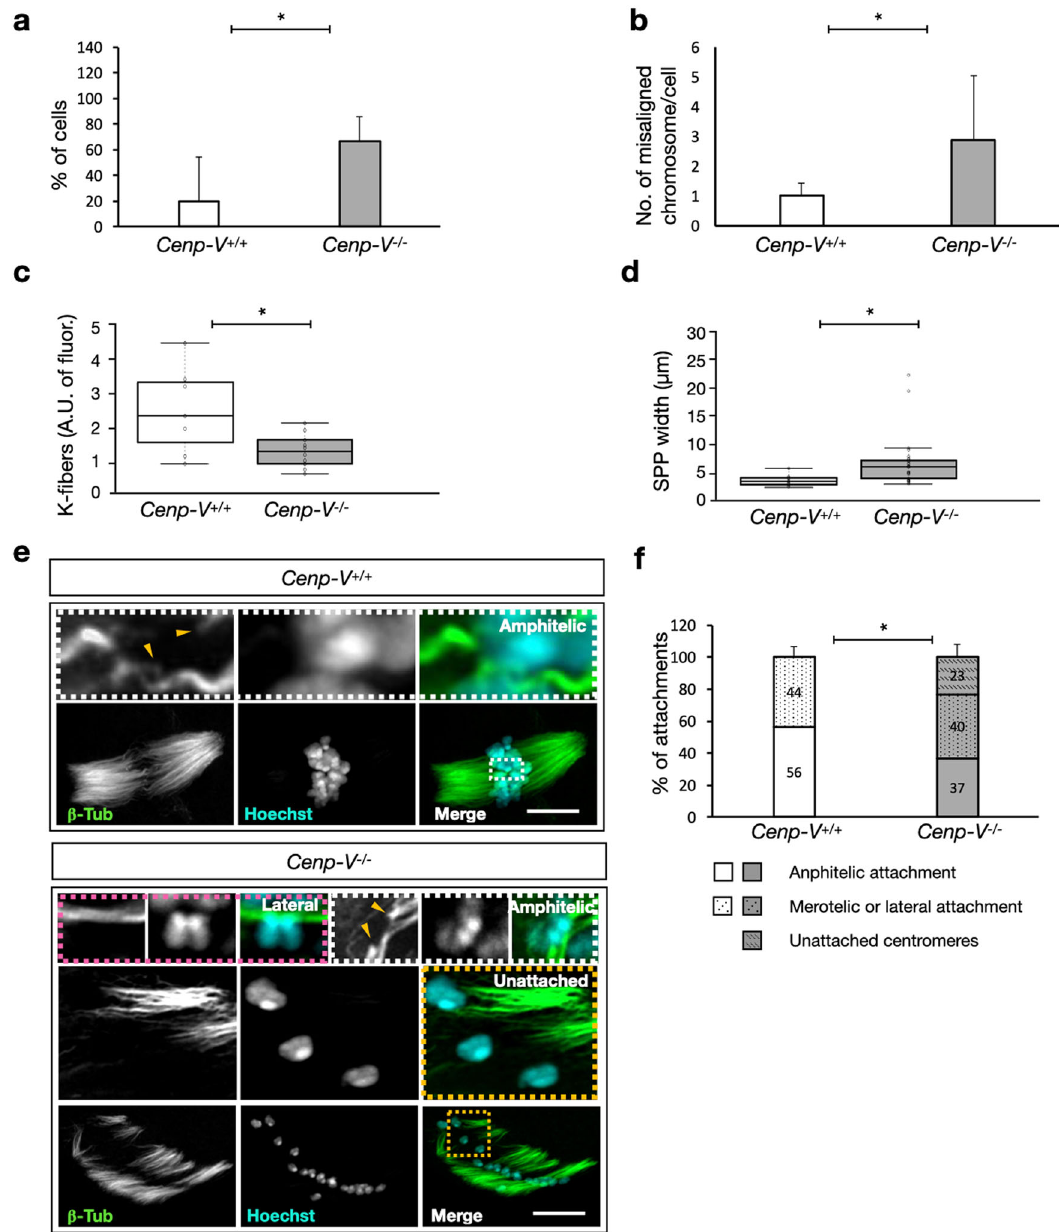
Fig. 7 Metaphase II spindle and chromosome-microtubule attachments in oocytes fi xed 5-7 h after polar body extrusion and cold treatment. ( a ) Percentage of cells showing chromosome misalignment. ( b ) Average number of chromosome misalignments per cell. ( c ) K- fi ber quanti fi cation expressed as arbitrary units (A.U) of fl uorescence ( d ) Spindle pole width (SPP width, w) quanti fi cation. ( e ) Example of chromosome-mt attachments in Cenp-V + / + and Cenp- V − / − oocytes. A maximum projection of the whole spindle is shown for each genotype. Single planes of z-stacks are shown for every attachment. One example of a proper amphitelic attachment to the centromeres is shown for Cenp-V + / + and Cenp-V − / − oocytes, indicated by a white dashed square. A merothelic or lateral attachment and three examples of unattached sister centromeres are shown for Cenp-V − / − oocytes, pink and yellow dashed square respectively. Microtubules are stained by anti ß-tubulin and DNA stained by Hoechst 33258. The tip of the K- fi ber attached to the sister centromere is indicated by a yellow arrow head. Centromeres are identi fi ed as the strongest region stained by Hoechst 33258. Images were taken on an Airyscan confocal microscope, the z plane distance was 145nm. See also supplementary Movies S10 and S11. Scale bar = 10 µ m ( f ) Chromosome-microtubule attachment quanti fi cation. Statistic: data were expressed as mean±SD and statistical differences were tested by a paired two tailed T - test (*** p <0.001,**p<0.01, *p<0.05). The exact p values are available in the source data fi le. Statistical differences refer to the average of all data points. ( c , d ) Data are represented as box plots where the middle line is the median, the lower and upper boxes correspond to the fi rst and third quartiles and outlying points are plotted beyond the end of the whiskers. ( a , b , c , d ) n = 54 cells and ( f ) n = 79 attachments. All data come from 3 independent